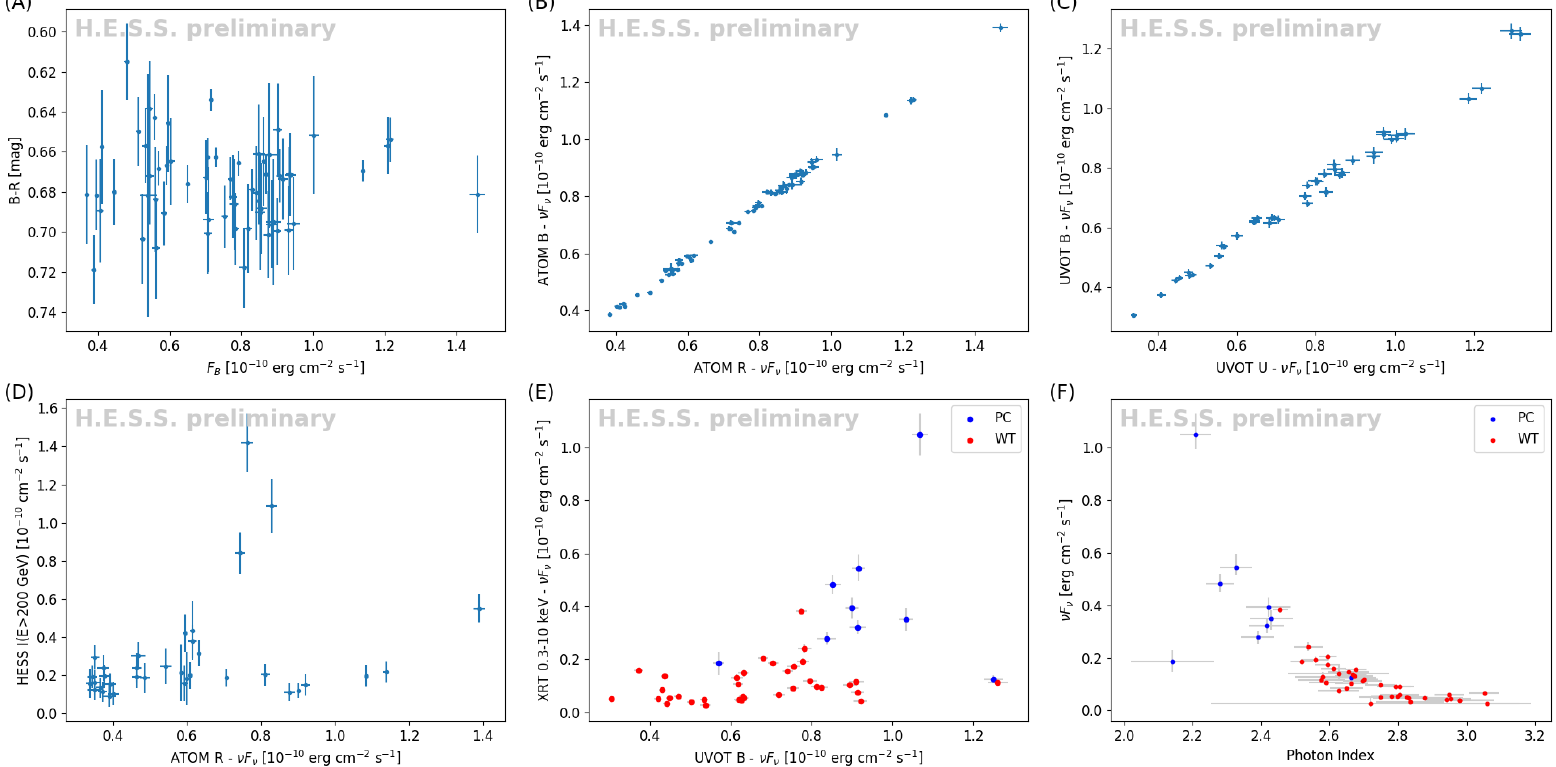
Figure 2. Comparisons of emission observed at different wavelengths. The following panels presents: ( A ): B − R color vs. the B-band energy flux. ( B ): Comparison of B and R fluxes as observed with ATOM. ( C ): Comparison of optical U and B fluxes as observed with UVOT. ( D ): VHE γ -ray photon flux of the source also as a function of the B-band energy flux. ( E ) Comparison of X-ray flux in the energy range of 0.3–10keV and optical flux in B band as observed with Swift-XRT and Swift-UVOT, respectively. Different colors are used to denote PC (blue) and WT (red) mode X-ray observations. ( F ) X-ray flux in the energy range of 0.3–10keV and corresponding photon index. Different colors are used to denote PC (blue) and WT (red) mode X-ray